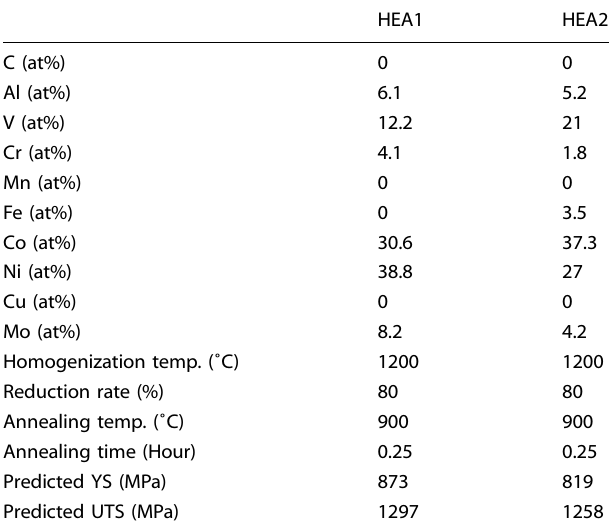
Table 2. Results of the inverse prediction using the present work and conditional random